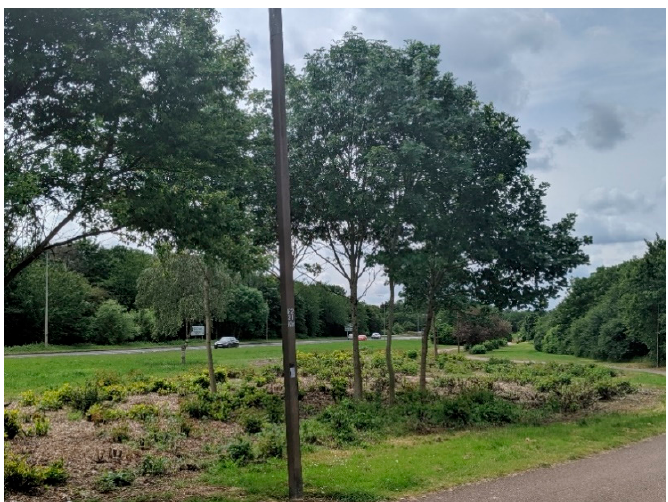
Figure 7. A Redway, aligning with the grid system. Pedestrians and cyclists are a considerable distance from traffic, separated by maintained greenspace. Permission granted by Marston.